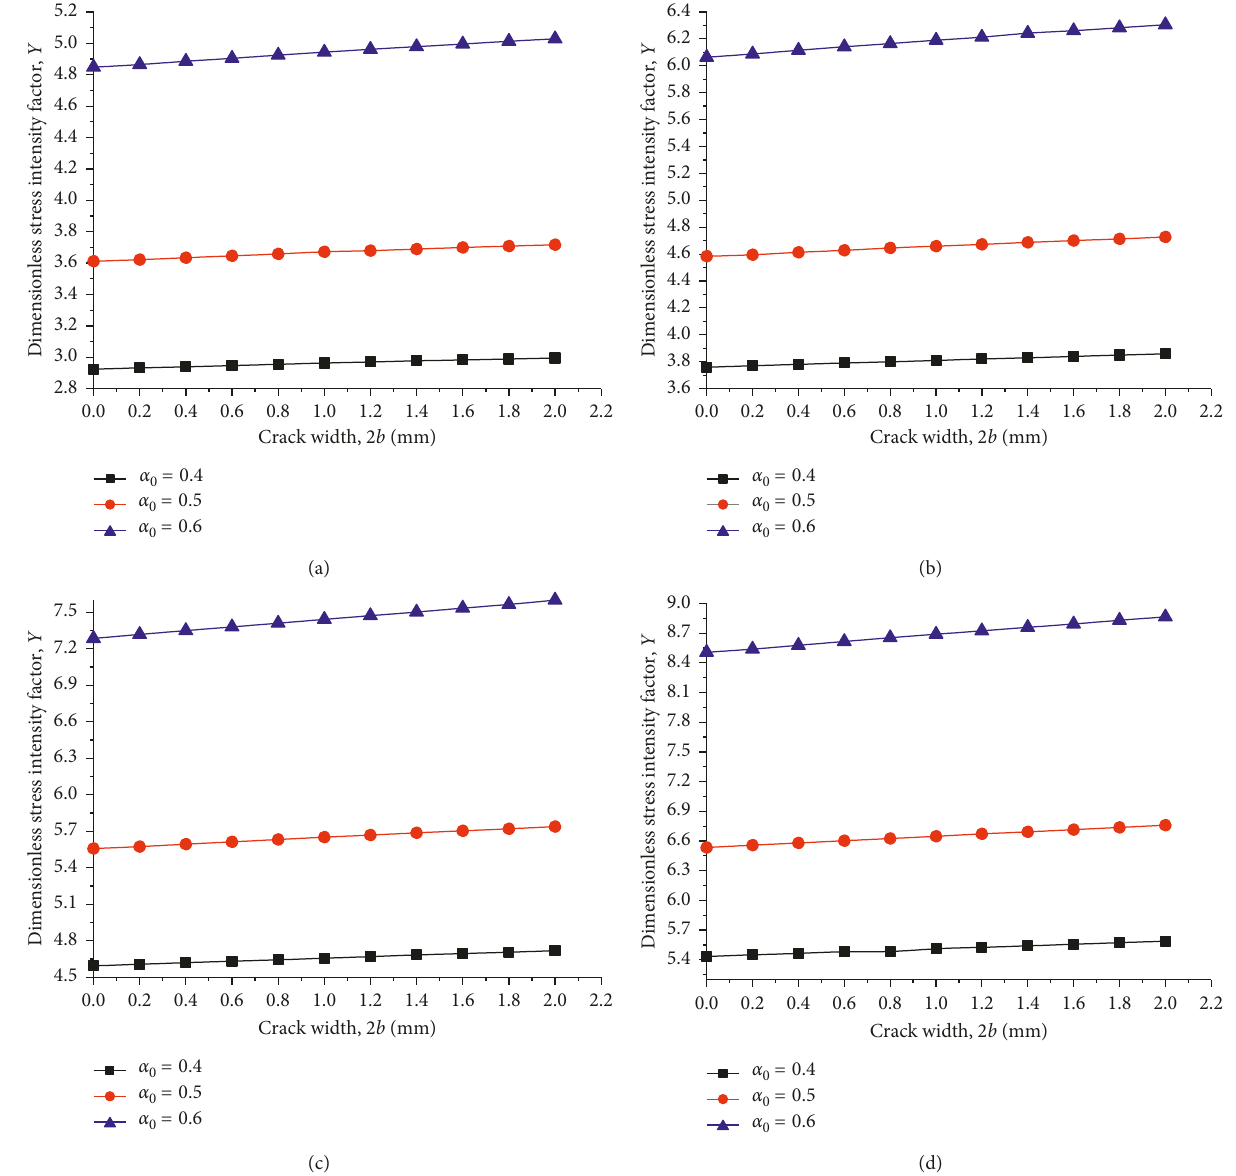
Figure 5: Dimensionless stress intensity factor variation diagram of NSCB specimens. (a) α